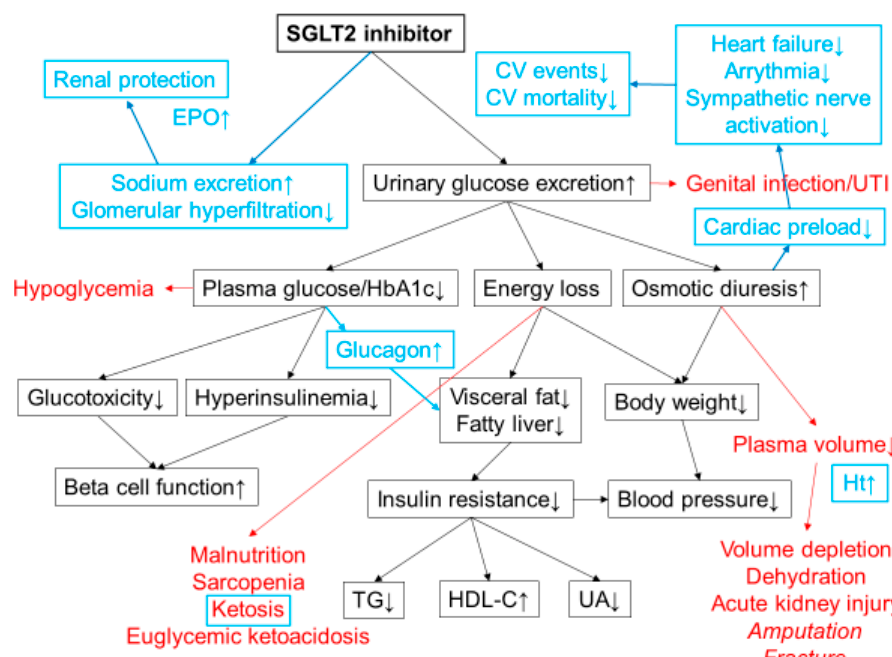
Figure 1. Mechanisms of action of SGLT2 inhibitors. SGLT2 inhibitors lower plasma glucose level by increasing urinary glucose excretion. Energy loss by SGLT2 inhibitor treatment promotes weight loss and improves insulin resistance and various metabolic parameters. Possible adverse effects are shown in red. Increased risk of lower-extremity amputation and bone fracture has been reported in a clinical trial with canagliflozin. The cardiorenal benefits shown in CVOTs have revealed additional mechanisms of action of SGLT2 inhibitors that were unknown at the time of launch (highlighted in blue). Osmotic diuresis and natriuresis are likely to be the major mechanisms of the cardiorenal benefits of SGLT2 inhibitors. Increases in blood ketone bodies and hematocrit may also contribute to the cardiorenal benefits. CV; cardiovascular, TG; triacylglycerol, HDL-C; high density lipoprotein cholesterol, UA; uric acid, Ht; hematocrit, UTI; urinary tract infection, EPO; erythropoietin.